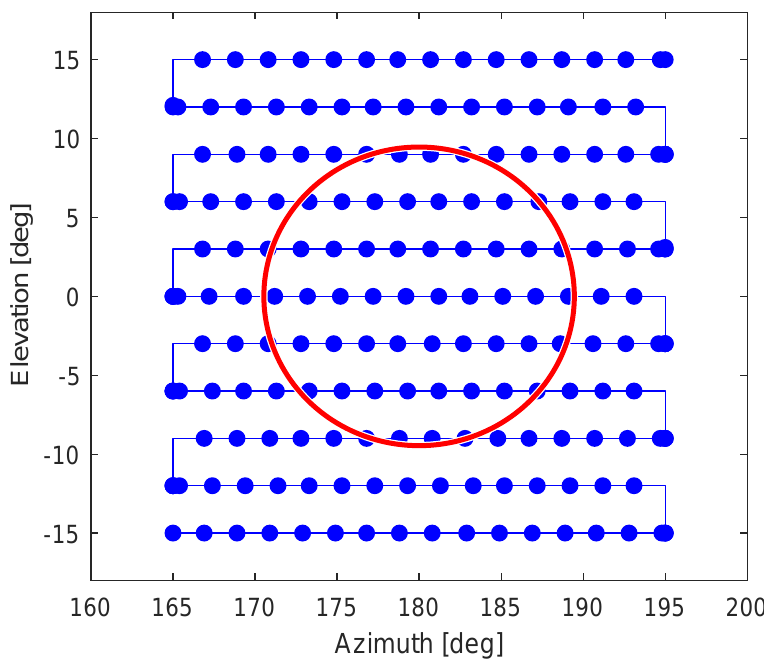
Figure 1. Path of the scanner (blue line) and measurement points (blue points) for the volumetric scan pattern with the outline of the rotor area (red line) at a distance of x / D =